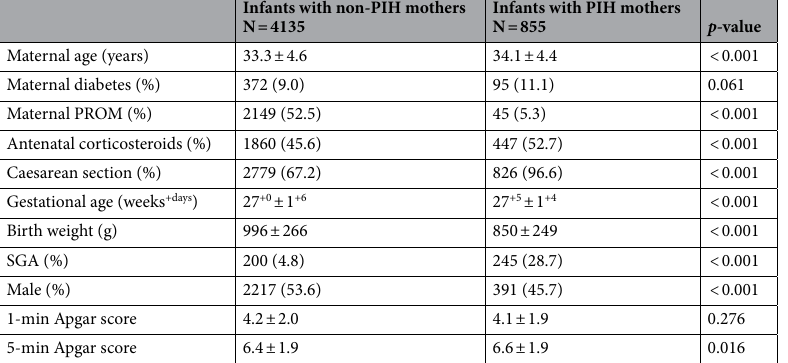
Table 1. Comparison of the baseline characteristics between infants with PIH mothers and infants with non- PIH mothers. Values are presented as means ± SDs or numbers (%). PIH Pregnancy-induced hypertension; PROM Premature rupture of membrane; SGA Small for gestational age; SD Standard deviation.